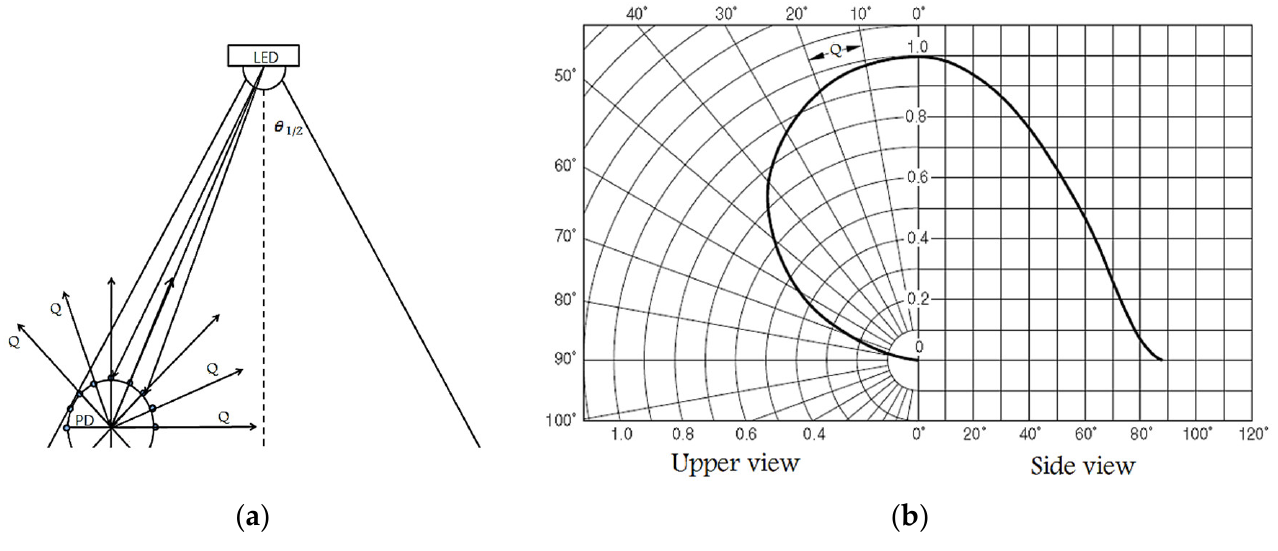
Figure 5. AOA based on circular PD array. ( a ) shows the radius of the PD array, and ( b ) illustration of the LED’s responsiveness.